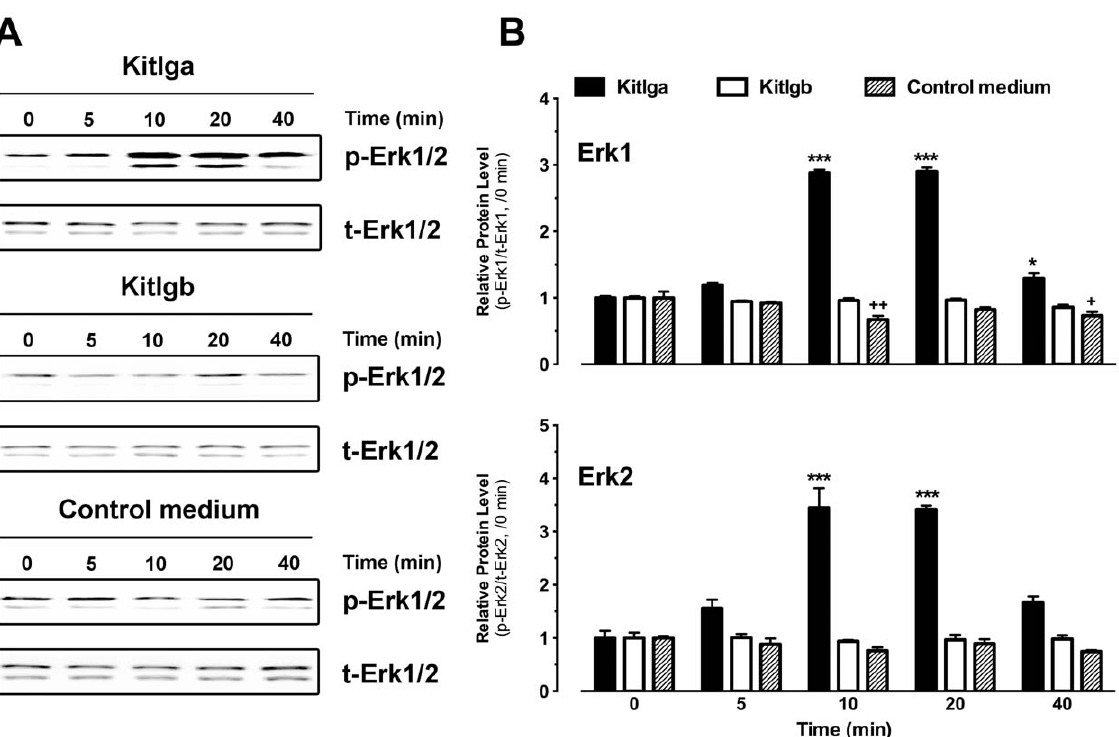
Figure 10. Effects of Kitlga and Kitlgb on MAPK phosphorylation in mature and ovulated oocytes. (A) Western blot analysis of MAPK (Erk1/2) phosphorylation in response to Kitlga (200 m l Kitlga conditioned medium + 200 m l control medium per ml), Kitlgb (400 m l/ml Kitlgb conditioned medium) and control medium (400 m l per ml). (B) Densitometric quantification of Erk1 (upper) and Erk2 (lower) phosphorylation. The data were normalized to total Erk1 or Erk2 and expressed as the fold change compared to the first group at time 0 min (mean 6 SEM, n=3). */ + P , 0.05; ***/ +++ P , 0.001. p-Erk1/2, phosphorylated Erk1/2; t-Erk1/2, total Erk1/2.